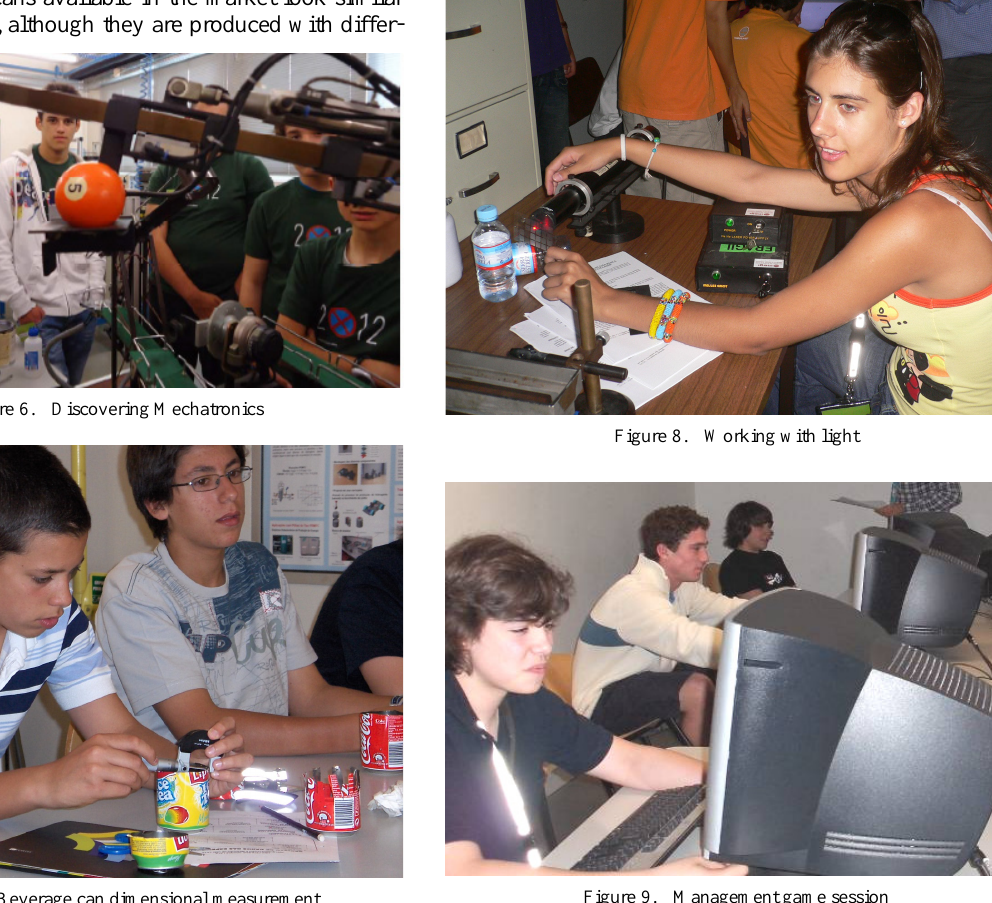
Figure 7. Beverage can dimensional measurement